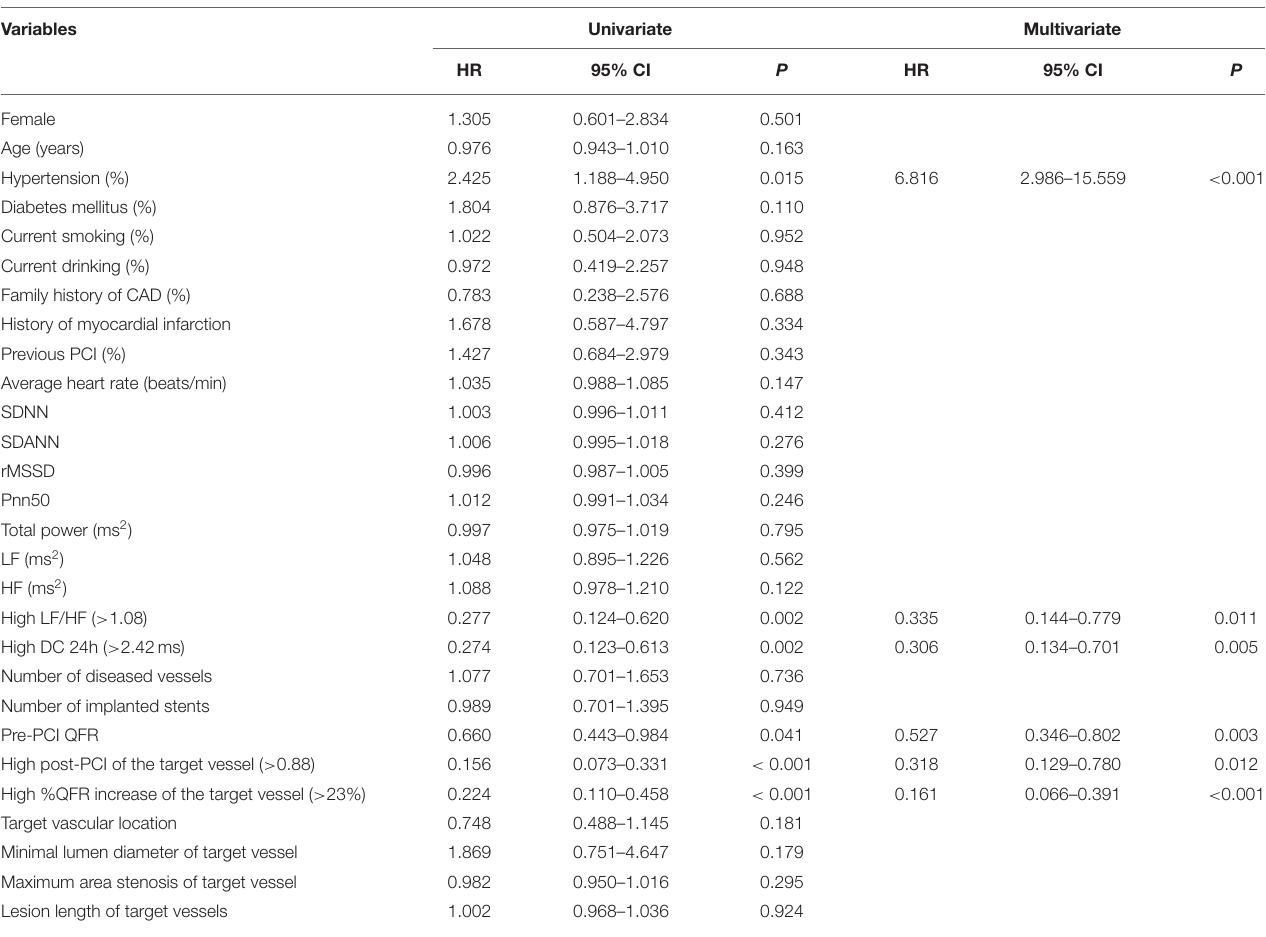
TABLE 7 | Potential predictors for the incidence of MACCEs in patients with NSTE-ACS who underwent PCI. Variables